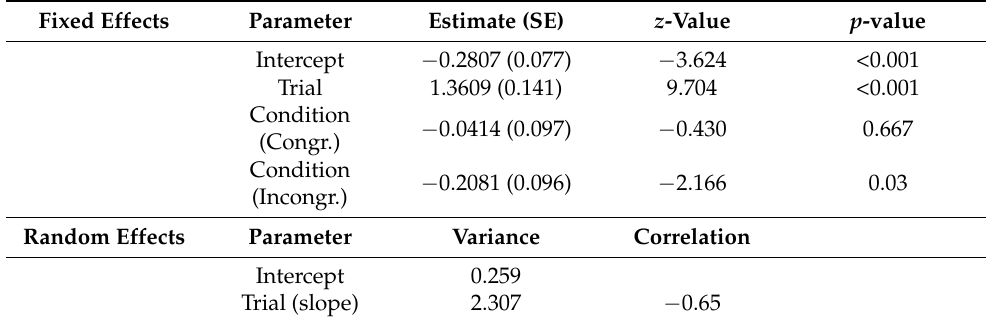
Table 2. Maximum likelihood estimates of fixed and random effect, z -values for regression coefficients, and variance of the random components of the best model.